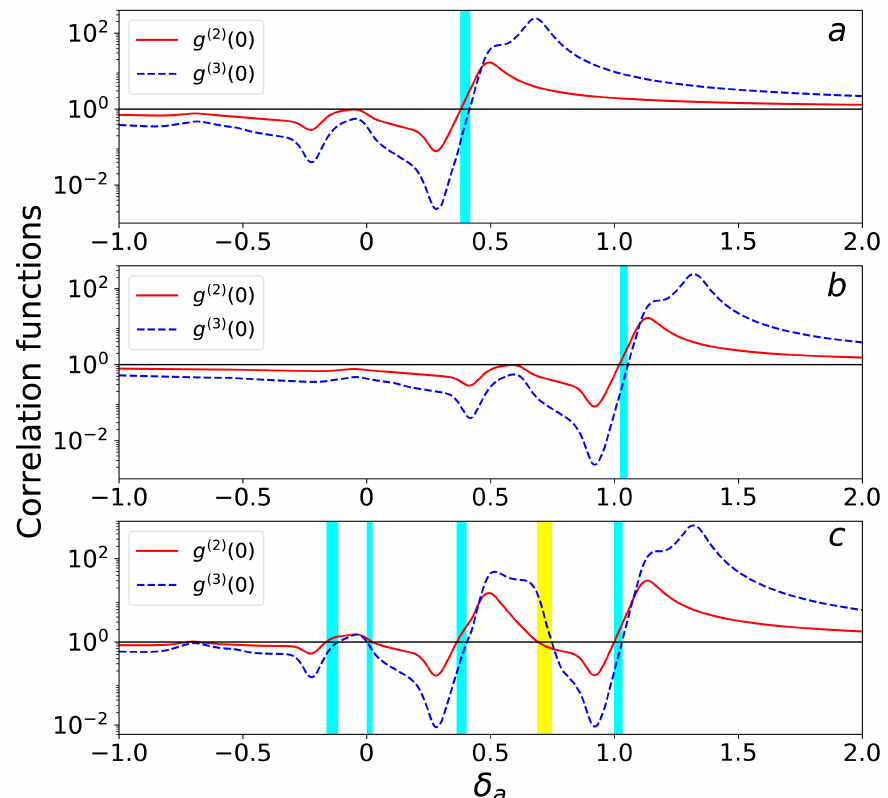
Figure 5. The equal-time SOC function g ( 2 ) ( 0 ) and TOC function g ( 3 ) ( 0 ) of the cavity field versus the driving detuning δ a for various values of the impurity initial state parameters: ( a ) C e = 0, C g = 1, √ ( b ) C e = 1, C g = 0, and ( c ) C e = C g = 2/2. Other parameters are λ s = 0.5, Ω b = 1, ω (cid:48) √ 0.08, λ CB = 2/2, λ iB = 1, η = 0.01, γ c = 0.1 in units of Ω b